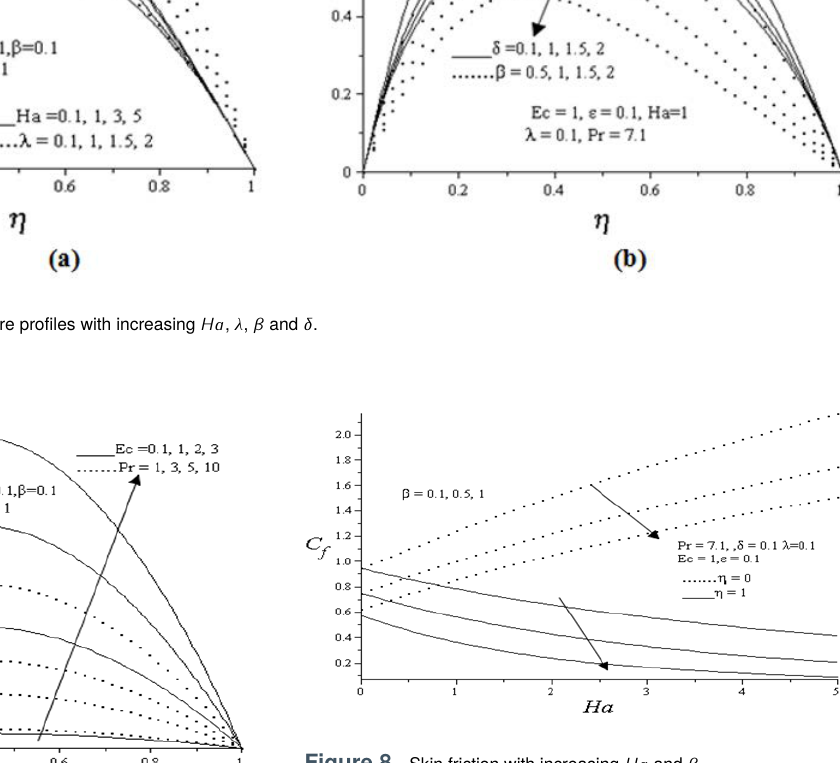
Figure 8. Skin friction with increasing Ha and β